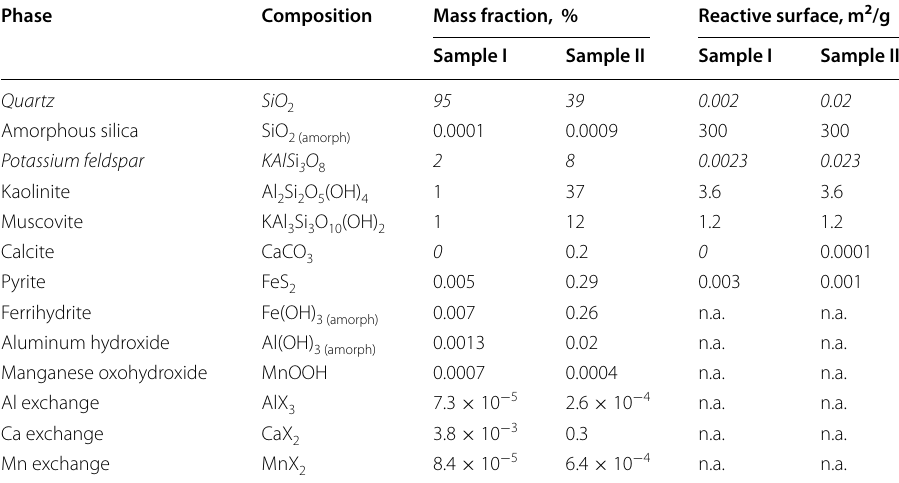
Phases printed in italics were excluded after sensitivity analysis or initial simulations. Mass fractions were taken from Müller et al. (2017), except amorphous aluminum hydroxide, which was calculated from sequential extraction data (ibid.). Reactive surfaces were calculated from specific surface values collected in the RES 3 T database